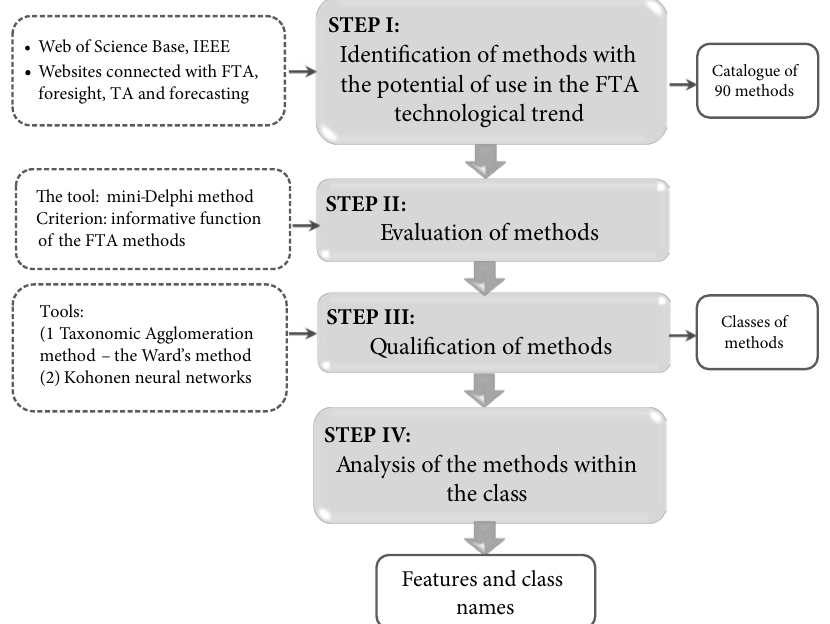
Fig. 1. Methodology for the classification of methods of future-oriented technology